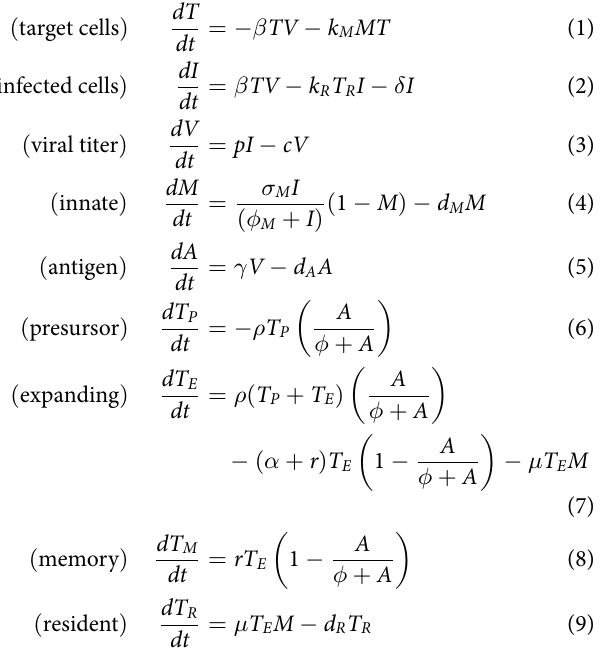
TABLE1 | Modelparametersunlessotherwisespecifiedinthefigurelegend . Model parameter Symbol